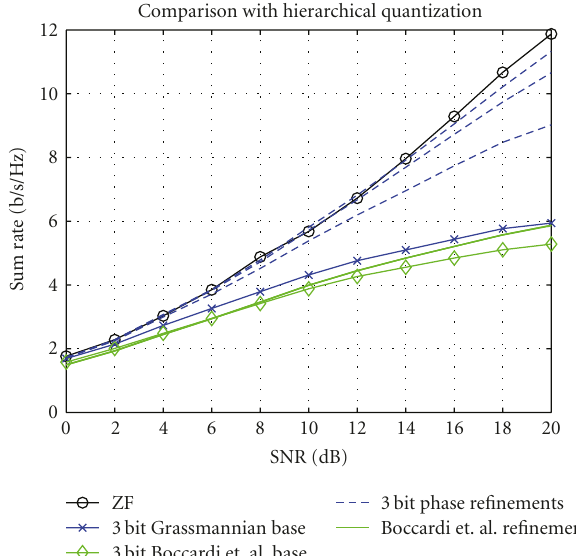
Figure 5: Sum rate performance comparison of multiuser MIMO with N t = U = 2 in a spatially correlated channel. The dashed lines correspond to increasing numbers of 3 − bit phase refinements while the solid lines with no markers correspond to increasing numbers of refinements for the Boccardi et. al. algorithm (which happen to overlap).